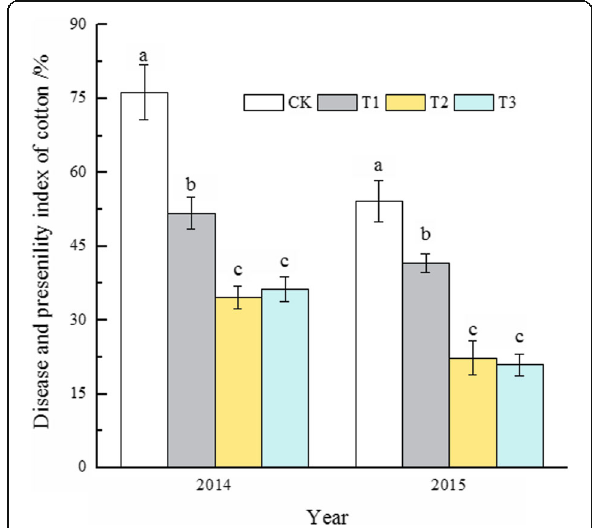
Fig. 10 Disease and presenility index (DPI) of cotton in different treatments in 2014 and